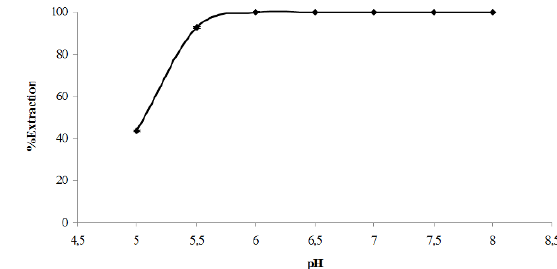
Figure 1. Variation of extraction efficiency (%) with pH of aqueous solution. Aqueous solution: 1 mg L -1 Cd 2+ , 0.1 M HEPES, 0.1 M NaNO . Organic solution : 0.1M Cyanex 272 in 3 kerosene.